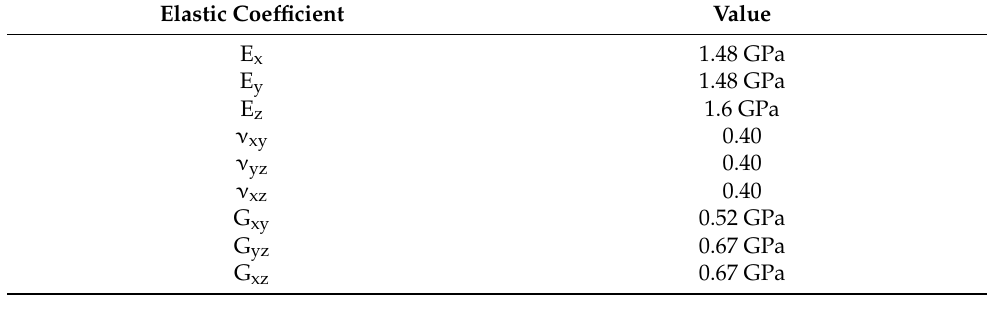
Table 8. Input of the Ansys simulation.